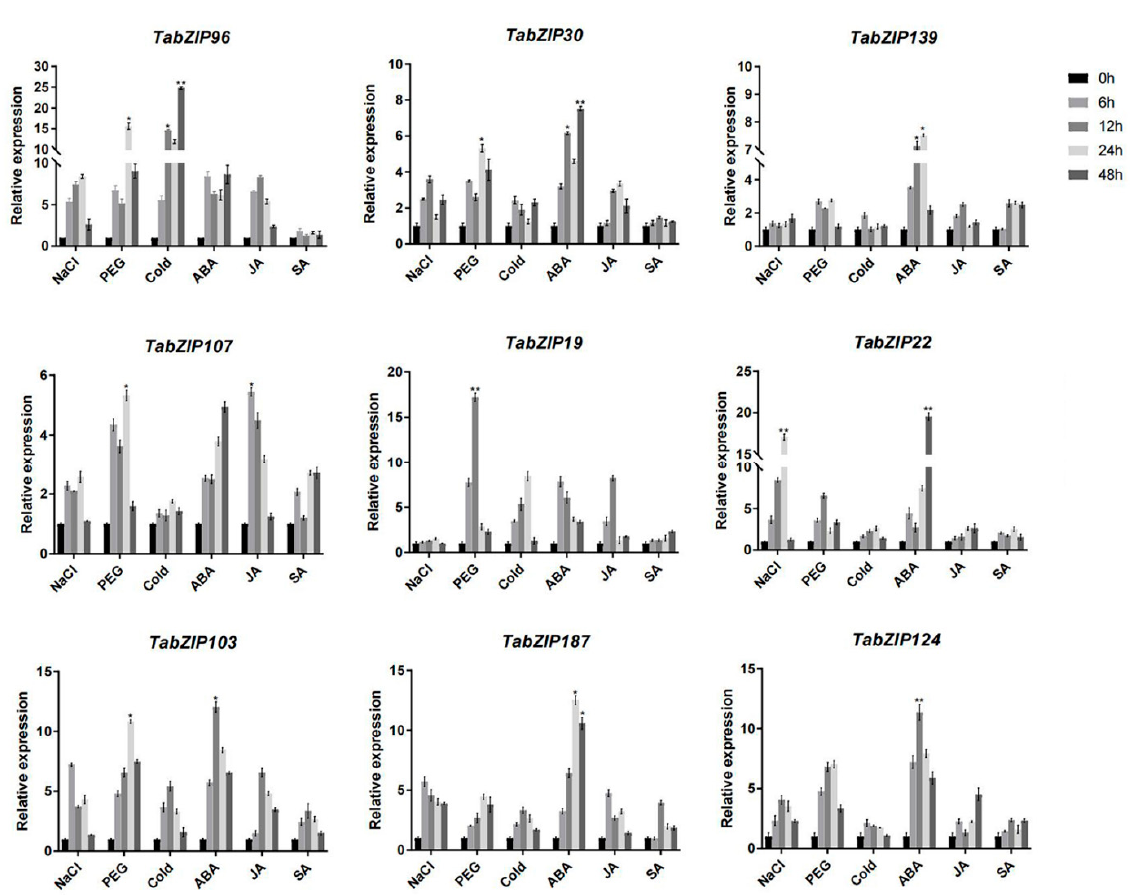
Figure 7. Relative expression analysis of 9 genes in the TabZIP gene family under cold stress, drought stress, salt stress, ABA treatment, JA treatment, and SA treatment in wheat. All values in the figure are mean ± SD ( n = 3), p values (versus 0 h) were corrected with ANOVA, p < 0.05 indicates significant difference, indicated by *; p < 0.001 indicates high significance, indicated by **.